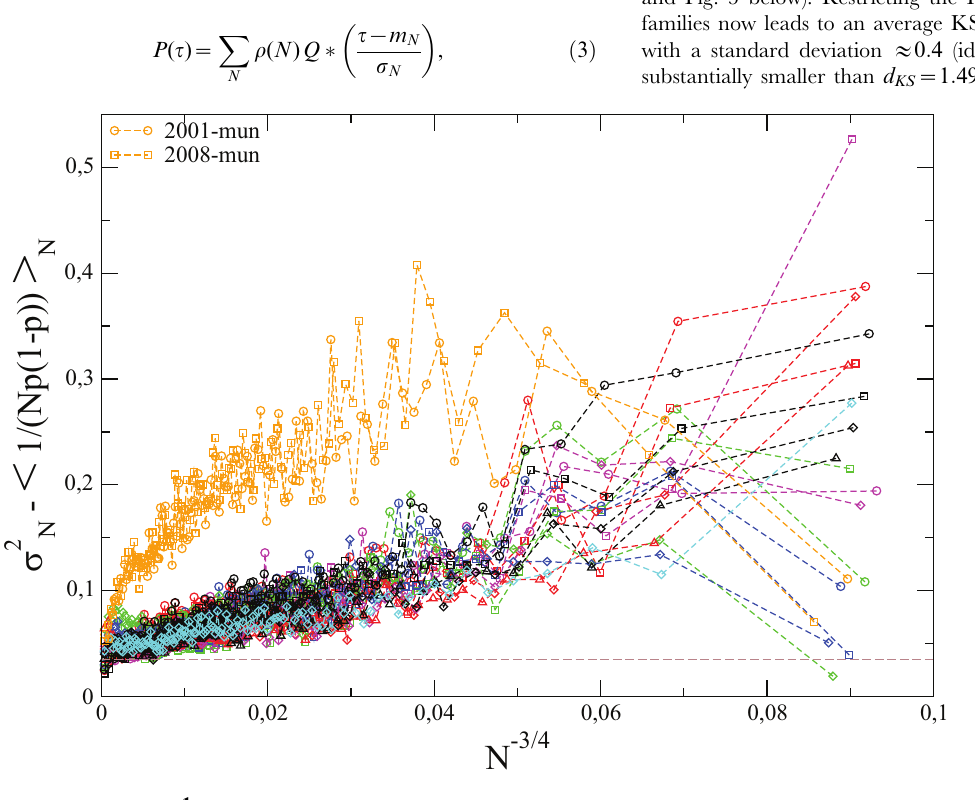
{ S 1 T N as a function of N { 3 = 4 for French elections. Each point comes from around 300 communes of size & N . Dashed Figure 3. s 2 N Np ( 1 { p ) & 0 : 035 as extracted from the spatial correlations of t (cf. Tab. 7). The 1998 and 2004 Re´gionales elections are excluded here. line: b 2 s 2 w